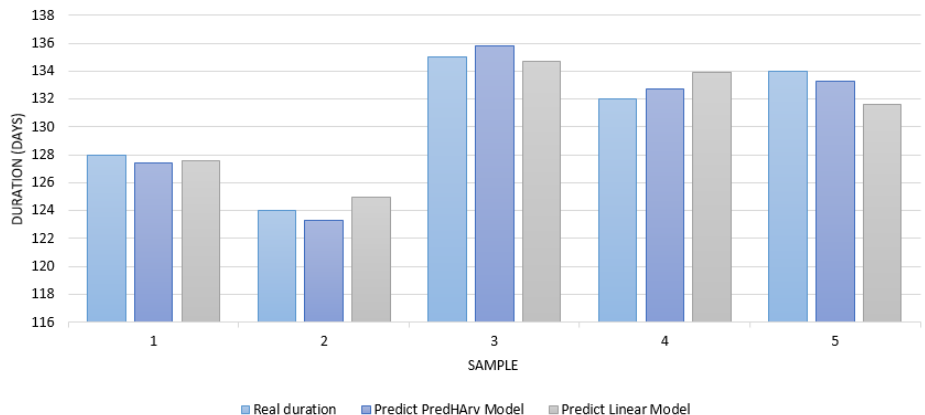
Figure 10. PredHarv model and linear model prediction results—DS2